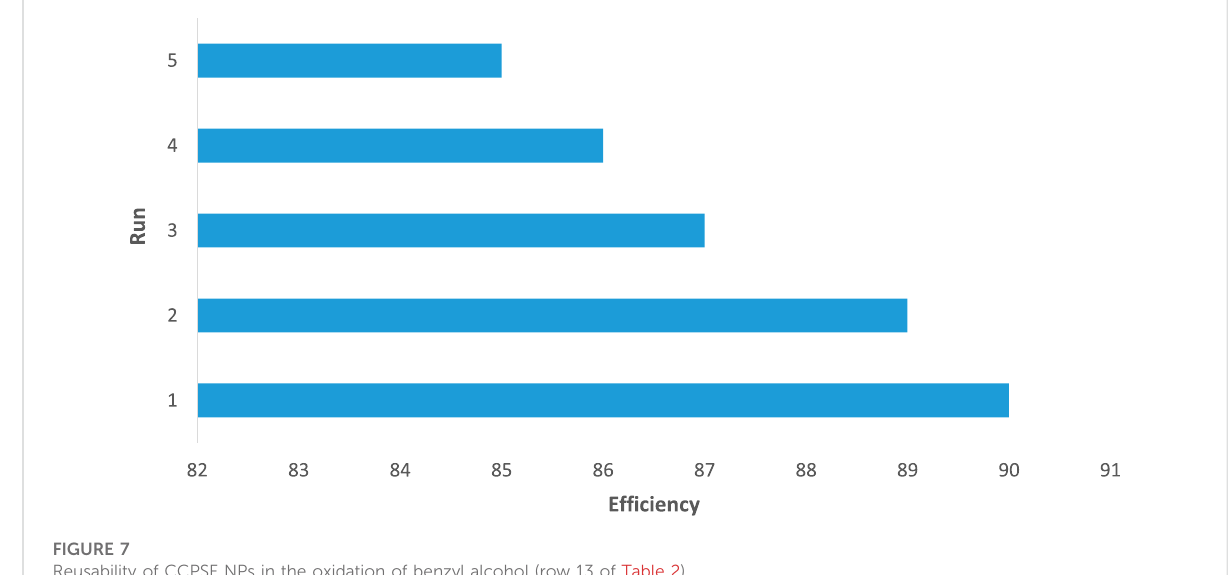
cobalt composite (I) and CCPSF NPs (II) are displayed in Figure 2. The thermal stability of CCPSF NPs was obtained at around 400 ° C. The high thermal stability of CCPSF NPs shows their high catalytic